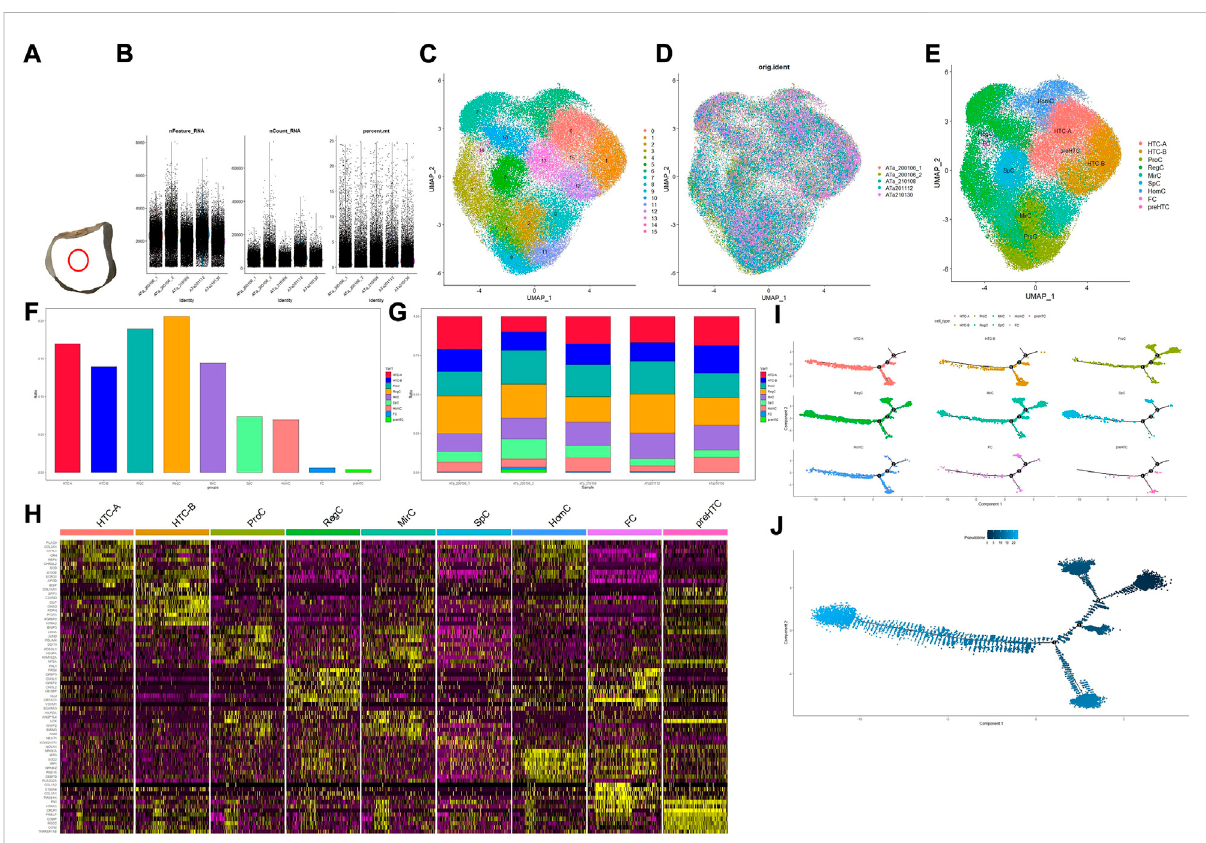
FIGURE 1 Overall process and results for scRNA-seq. (A) Location of the acquired cartilage sample; (B) basic information on quality control; (C) result for clustering; (D,G) distribution of the cartilage sample in the cluster and cell type, respectively; (E) result for cell-type annotation; (F) percentage for eachcelltype; (H) heatmapfortop10markersineachcelltype,andthecolorofthepointrepresentstheexpressionlevels; (I) pseudotimeanalysisfor different cell types; (J) development analysis for the overall developmental line, and the color of the point represents the trajectory order.